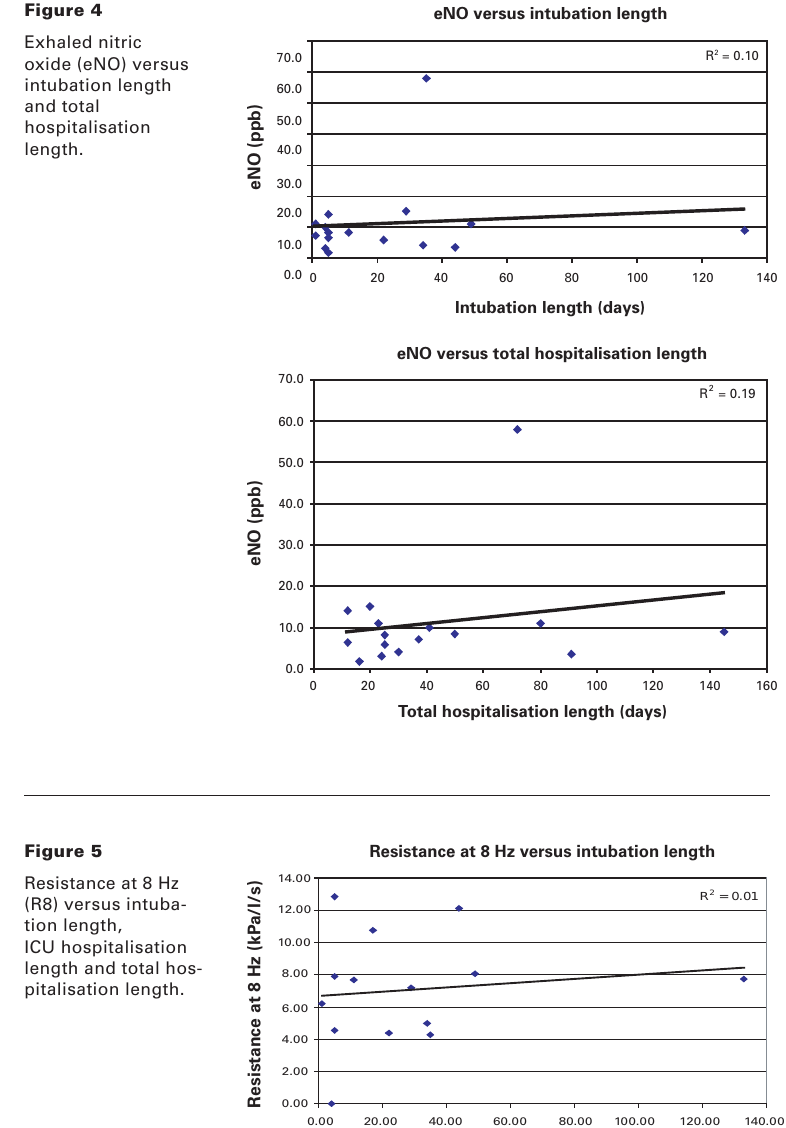
Figure 4 Exhaled nitric oxide (eNO) versus intubation length and total hospitalisation length.